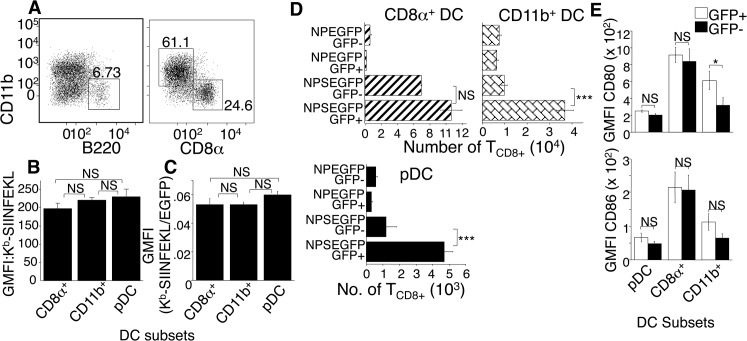
DC subsets are equally efficient in direct antigen presentation.(A) Mice were injected with ECTV, D-LN harvested and cells stained with antibodies to identify non-NK, non-B, non T cell, GFP+ CD11c+ DC subsets as: pDC (B220+CD11b-), CD8α (B220-CD8α +CD11b-), CD11b+ (B220-CD11b+CD8α -). Nos. represent % of cells in 3 representative experiments using 3 mice per condition. (B and C) Mice were injected with NP-S-EGFP or NP-EGFP, D-LN harvested and stained as described in (A), with the addition anti- Kb-SIINFEKL. Quantification of Kb-SIINFEKL expression and efficiency was determined as described in Fig 2C. Data are pooled from 3 experiments using 3 mice per condition. (D) Mice were injected with NP-EGFP or NP-S-EGFP, then D-LN cells were FACS sorted for EGFP+ or EGFP- pDC, CD8α +, or CD11b+ DC, as above. Each population was co-cultured with OT-I TCD8+ that were then analyzed for proliferation as above. Data are pooled from 3 experiments, using 15 mice per condition to obtain sufficient cells. (E) As in (A), except for addition of anti-CD80 and anti-CD86 antibodies. Data are pooled from 3 experiments. All graphs show (mean ± standard error), P values *p<0.05, **p<0.01, ***p<0.001, NS (not significant) using Student’s unpaired t-test.